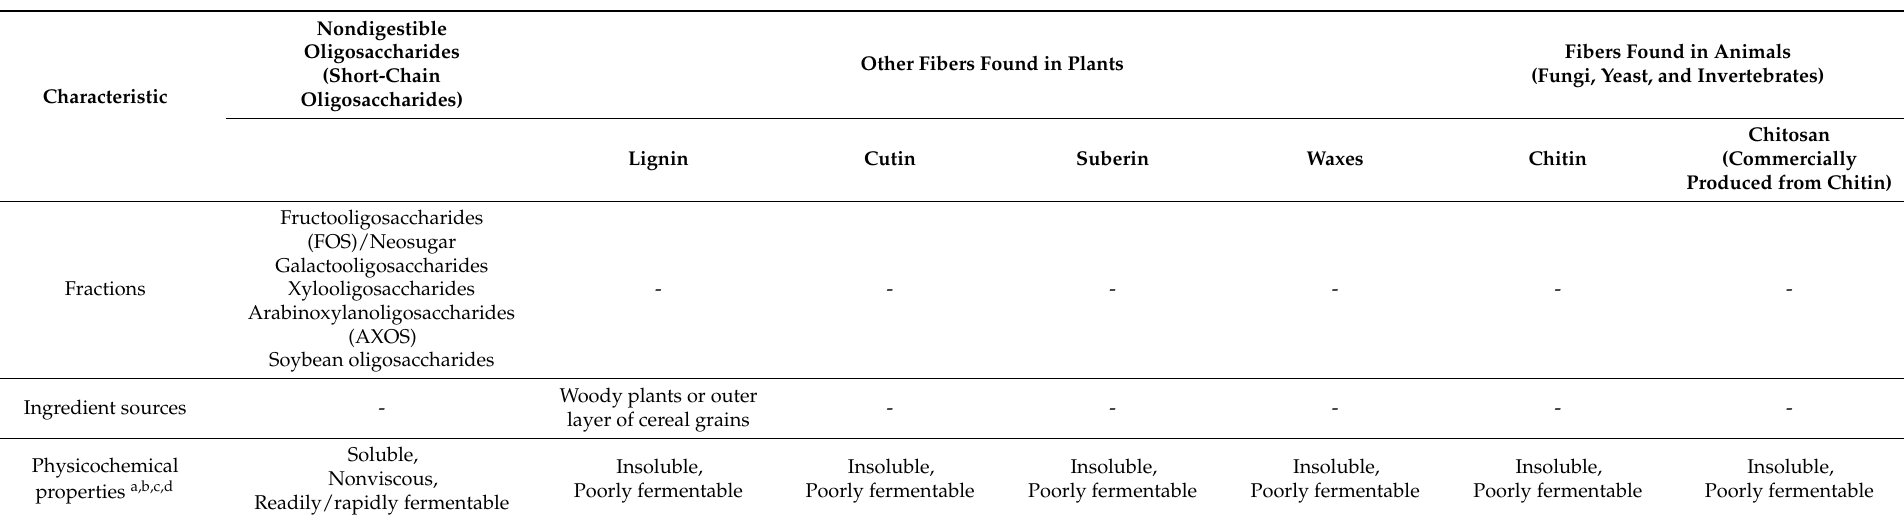
Table 4. Summary of carbohydrate fractions, ingredient sources, and physiological properties of nondigestible oligosaccharides and other fibers found in plants and animals (adapted from